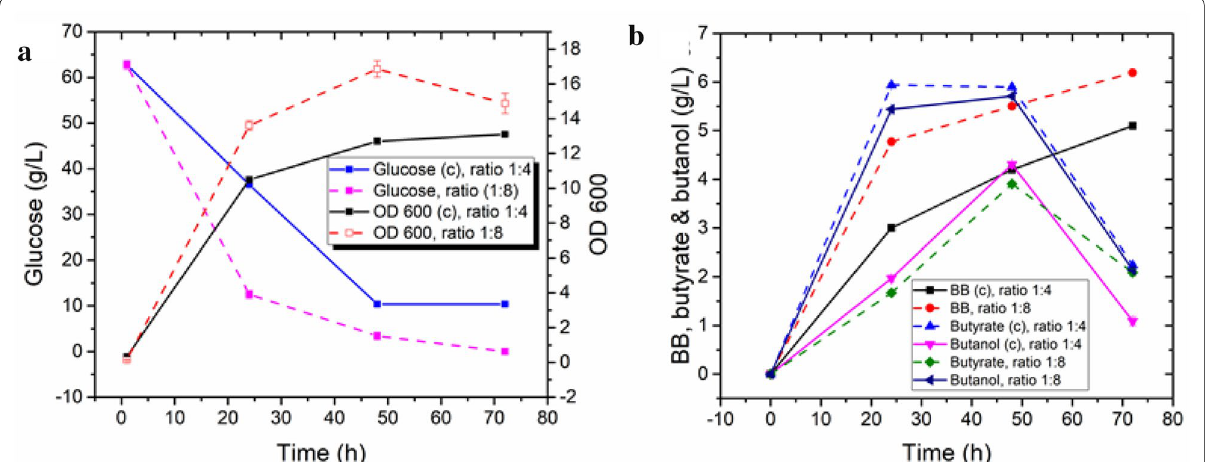
Fig. 5 Fermentation profiles of consortia with inoculation ratios (butyrate-producing strain: butanol-producing strain) of 1:4 (control, solid line) and 1:8 (dash line). a Profiles of optical density (OD 600 ) and glucose consumption. b Time-profiles of the butyrate, butanol, and butyl butyrate titers. The data represent the means SD from three independent ±